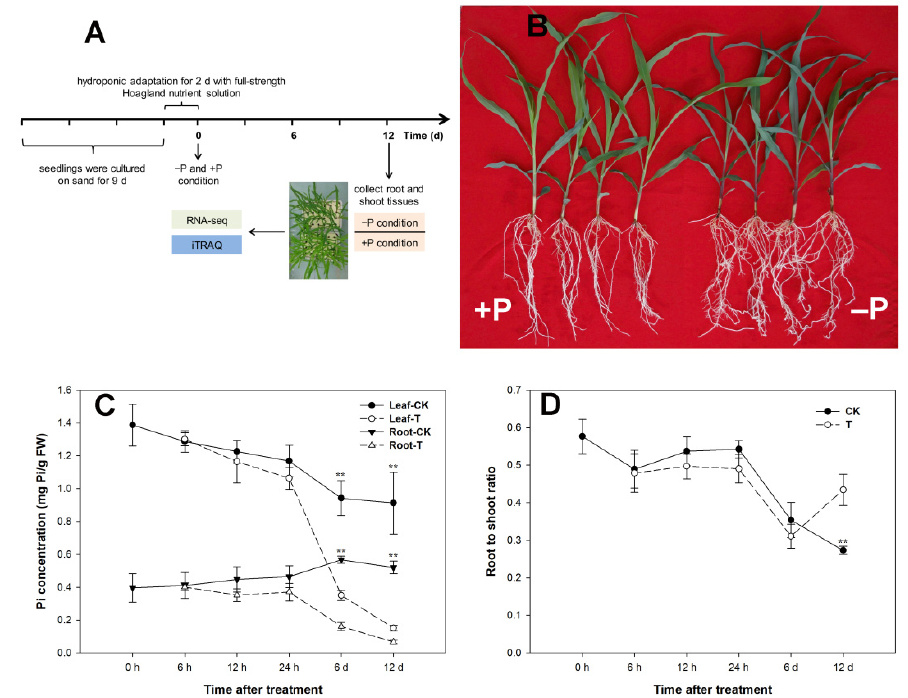
Figure 1. Phenotype analysis of 178 under Pi deficiency. ( A ) Schematic of the material preparation for transcriptomic and proteomic analysis. ( B ) Low Pi stimulated root growth and accumulated anthocyanin in shoots. ( C ) Pi concentration was measured in different tissues. ( D ) Root to shoot ratio analysis between control and low Pi treatment. Asterisks displays statistically significant analysis with Student’s t -test, ** represent p < 0.01.